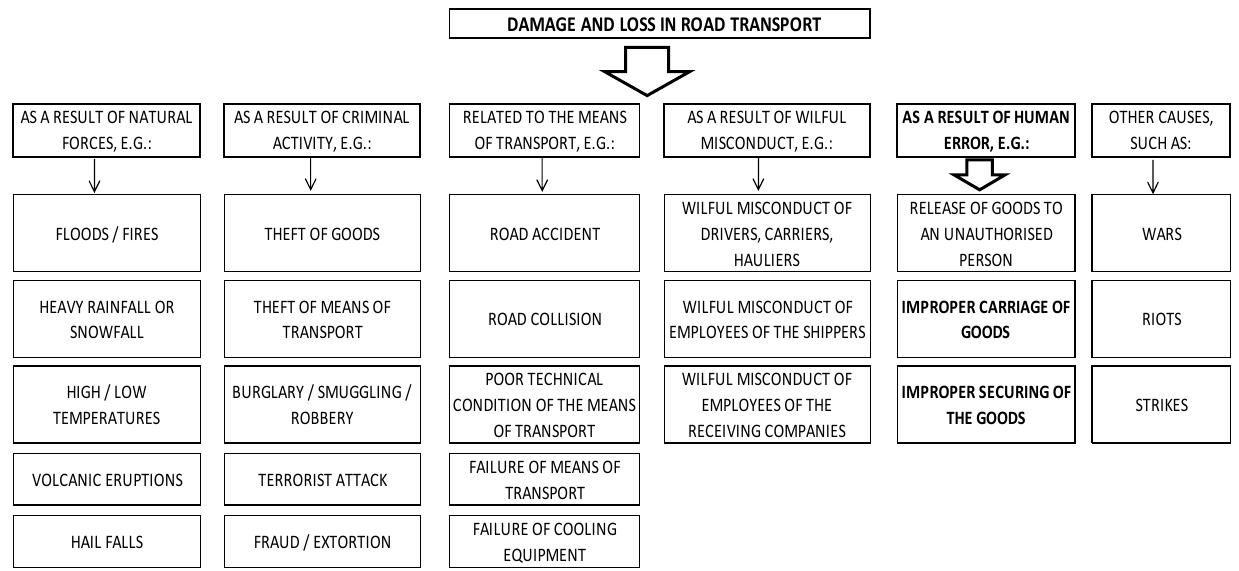
Figure 1. Factors giving rise to losses and damage in road transport.